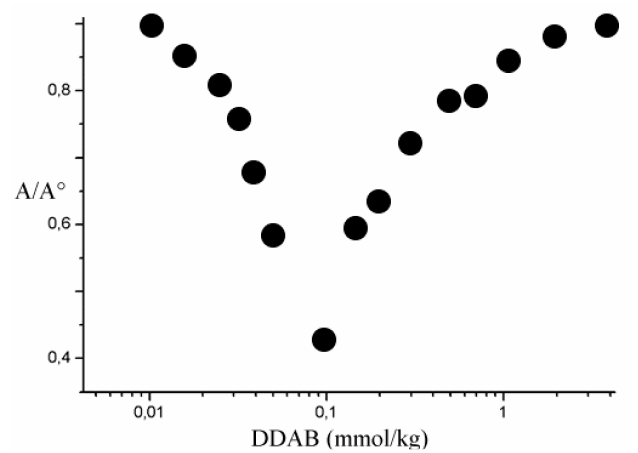
Figure 1. Normalized optical absorbance at 660 nm of a dispersion containing 0.01 wt.% of 1/1 ss-DNA/CNT complex upon titration with DDAB, at 25.0 °C. The data accuracy is within the symbols